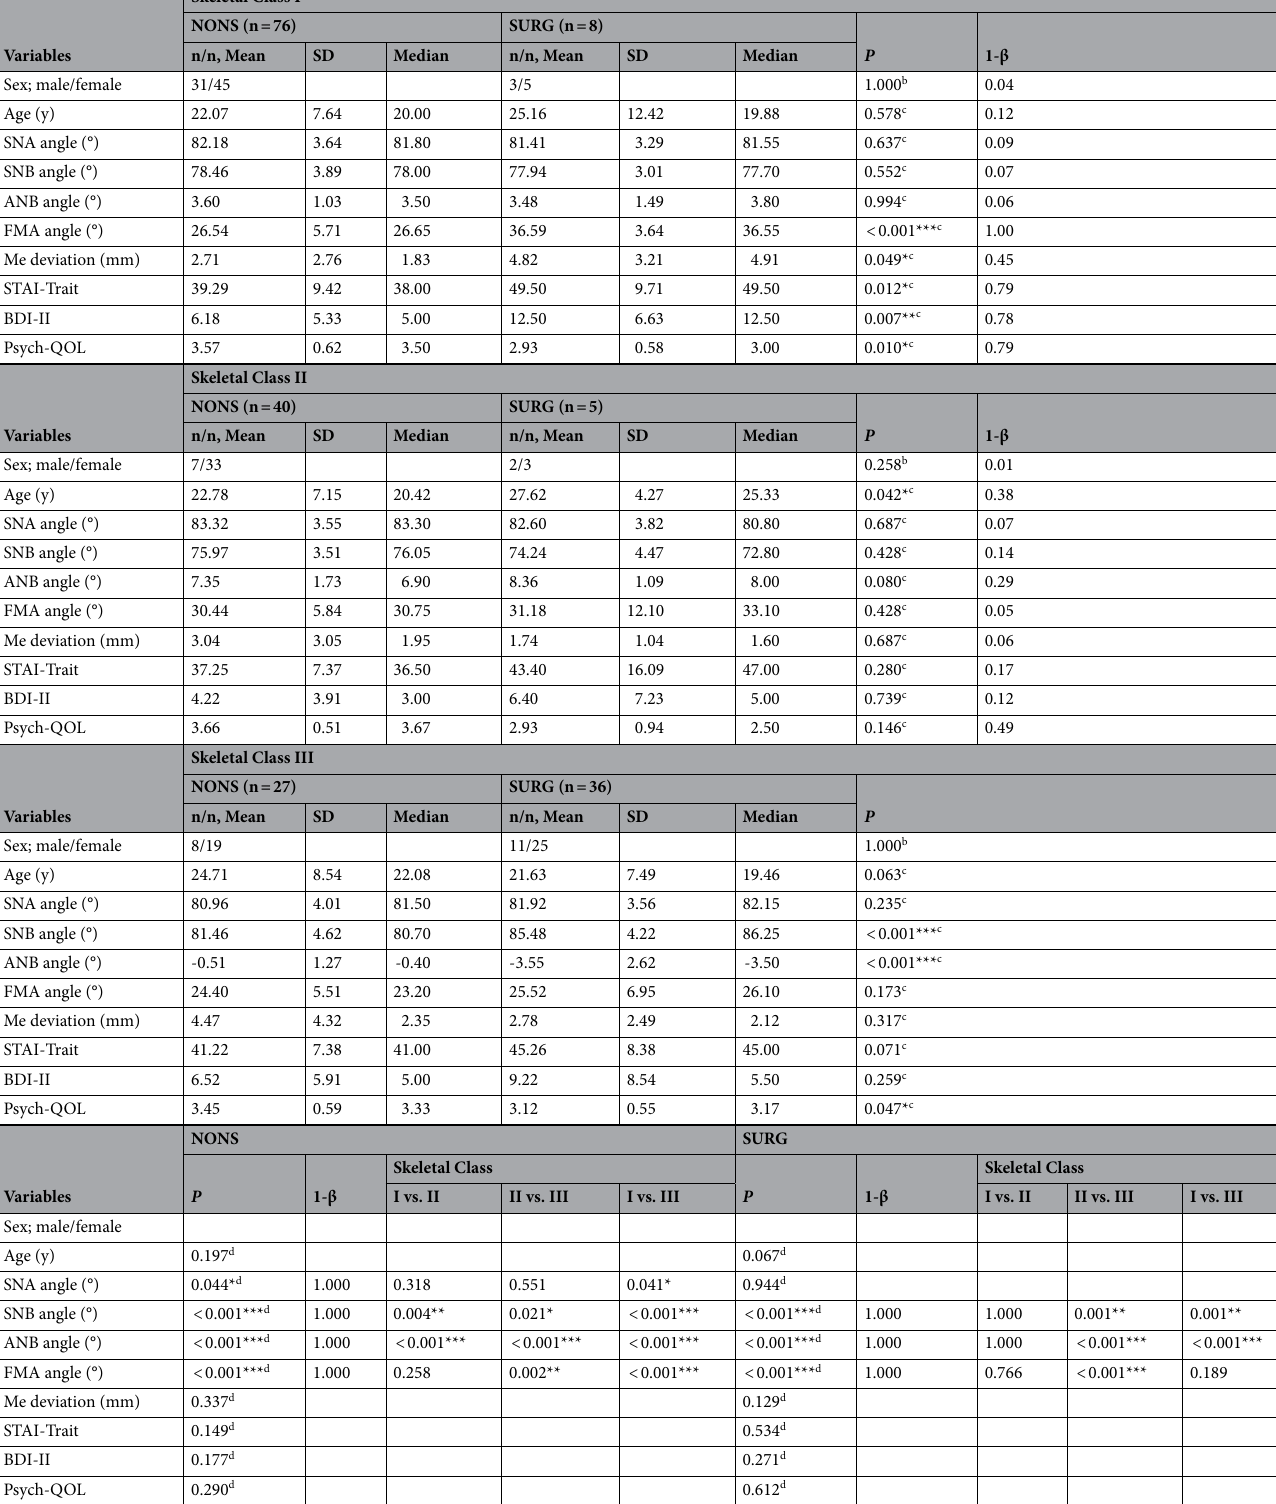
Table 4. Comparison of psychological assessments between groups classified by maxillofacial morphology a and choice of surgical orthodontic treatment. NONS non-surgical orthodontic treatment, SURG surgical orthodontic treatment, STAI State-Trait Anxiety Inventory, BDI-II Beck Depression Inventory-II, Psych-QOL